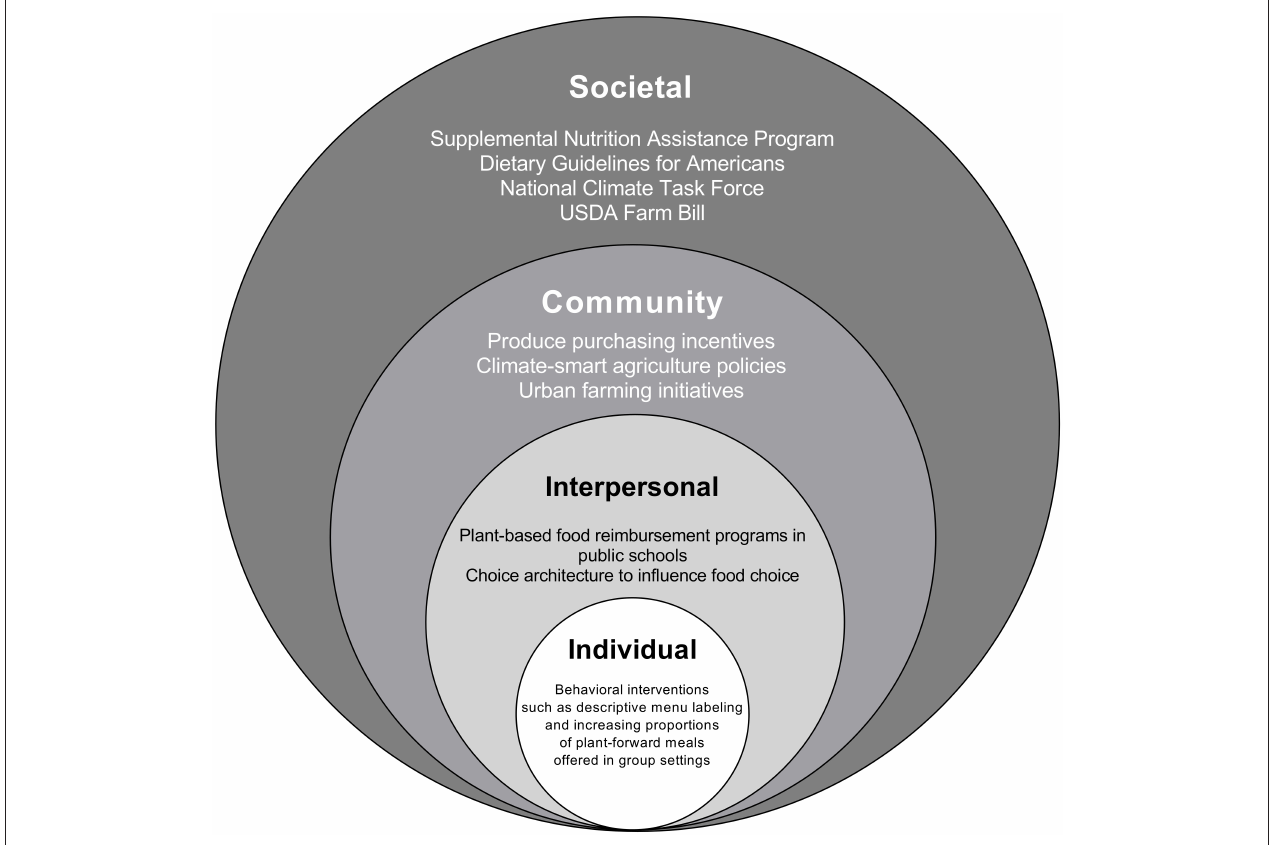
FIGURE 1 | National, state, and municipal policies in the US addressing food systems and sustainability according to the social-ecological